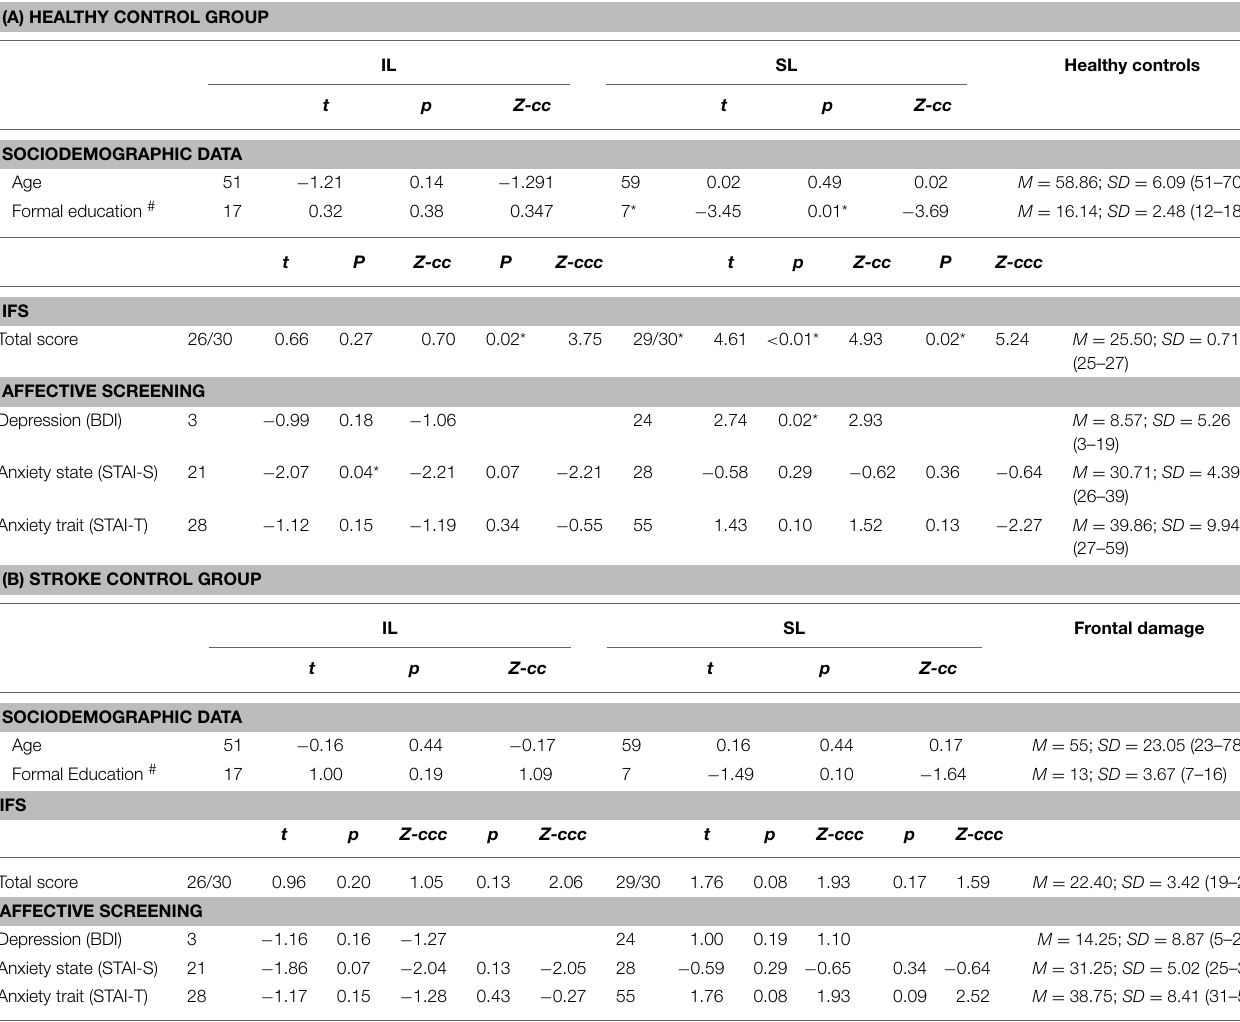
TABLE 1 | Demographic and neuropsychological